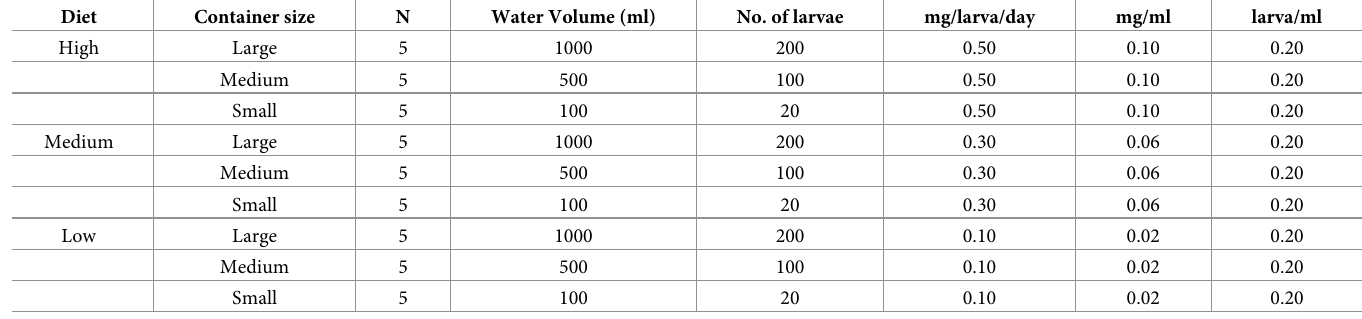
Table 1. Three diet treatments were provided to larvae held in three container sizes. Small (10.00 x 4.20 cm; Diameter x Depth), medium (18.00 x 11.00 x 6.00 cm; Length x Width x Depth) and large (27.00 x 20.70 x 11.00 cm; Length x Width x Depth). Diet Container